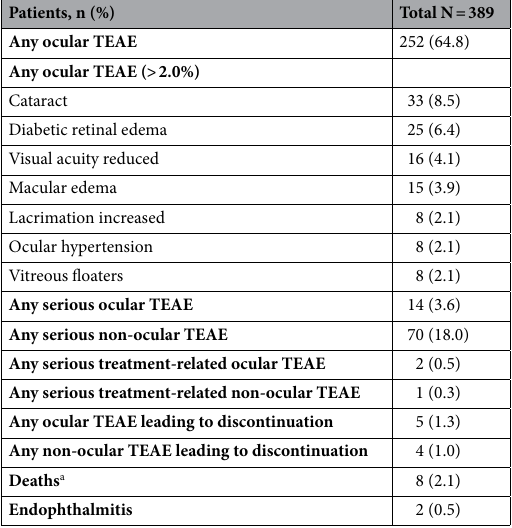
Table 2. Summary of the main safety events (SAS). a Assessed as unrelated to the study drug. SAS, safety analysis set; TEAE, treatment-emergent adverse